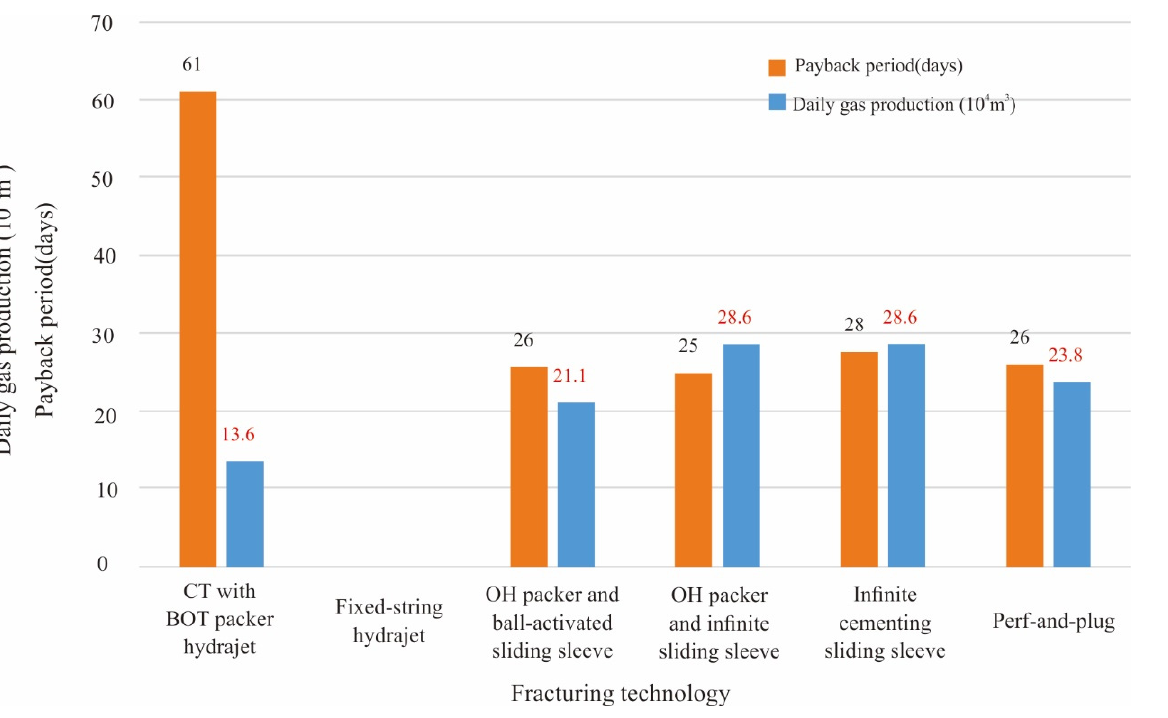
Table 7. Parameters and production of Class I horizontal wells in Block M.